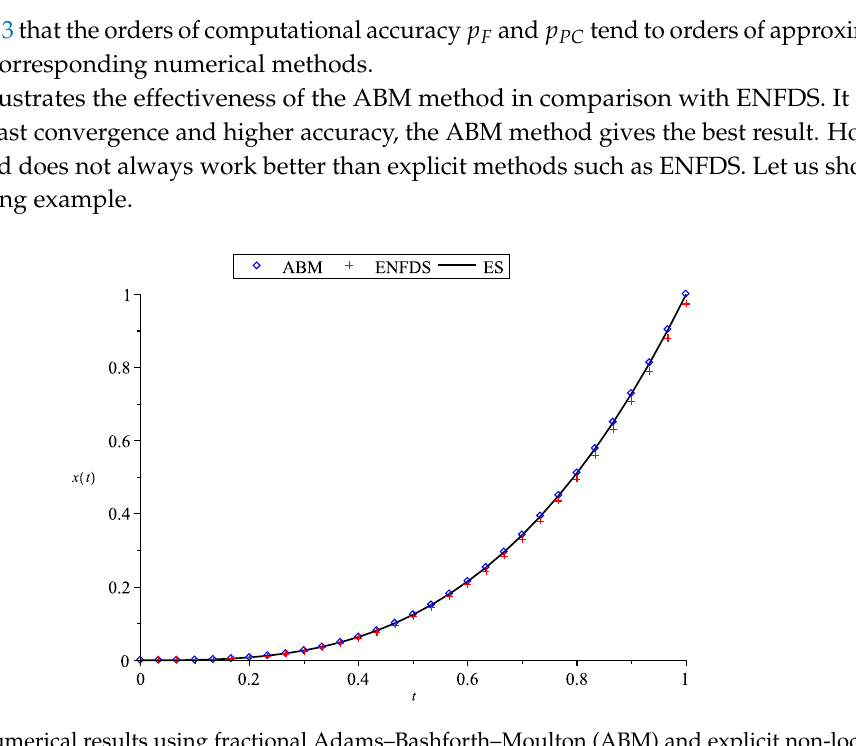
Figure 1. Numerical results using fractional Adams–Bashforth–Moulton (ABM) and explicit non-local finite-difference scheme (ENFDS) methods compared to exact solution (ES) for Example 1 at N =